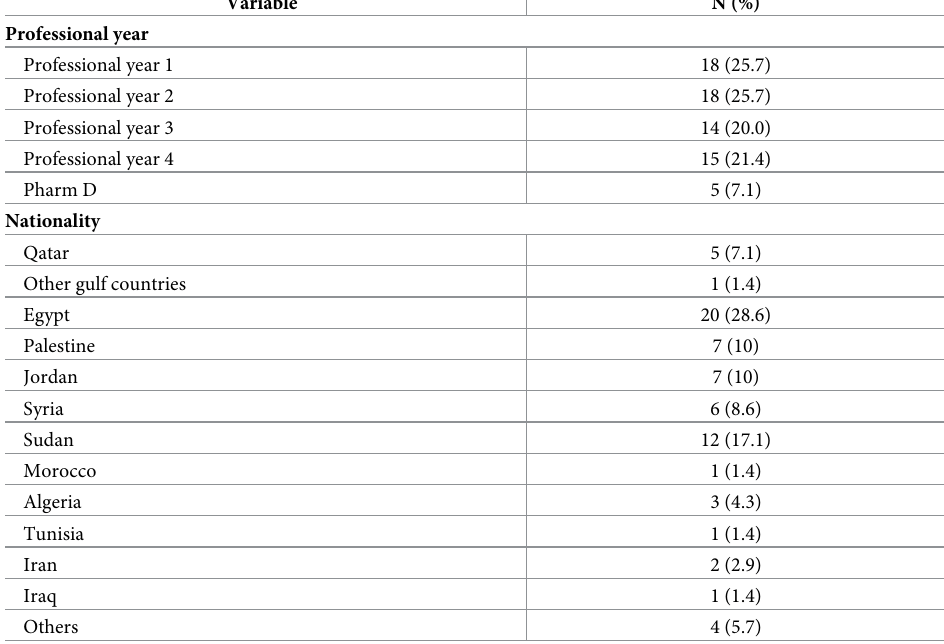
Table 4. Characteristics of surveyed pharmacy students at Qatar